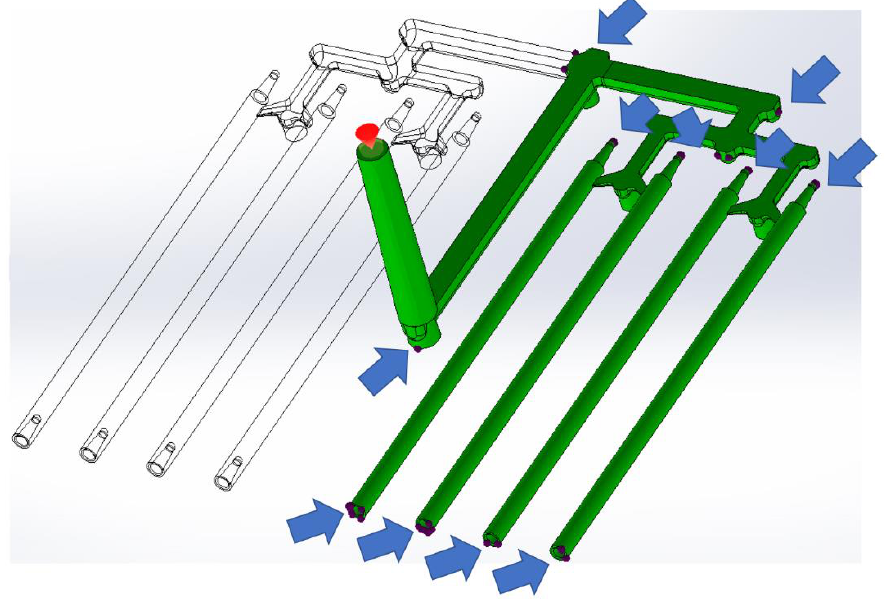
Figure 10. Air Figure 10. Air traps .